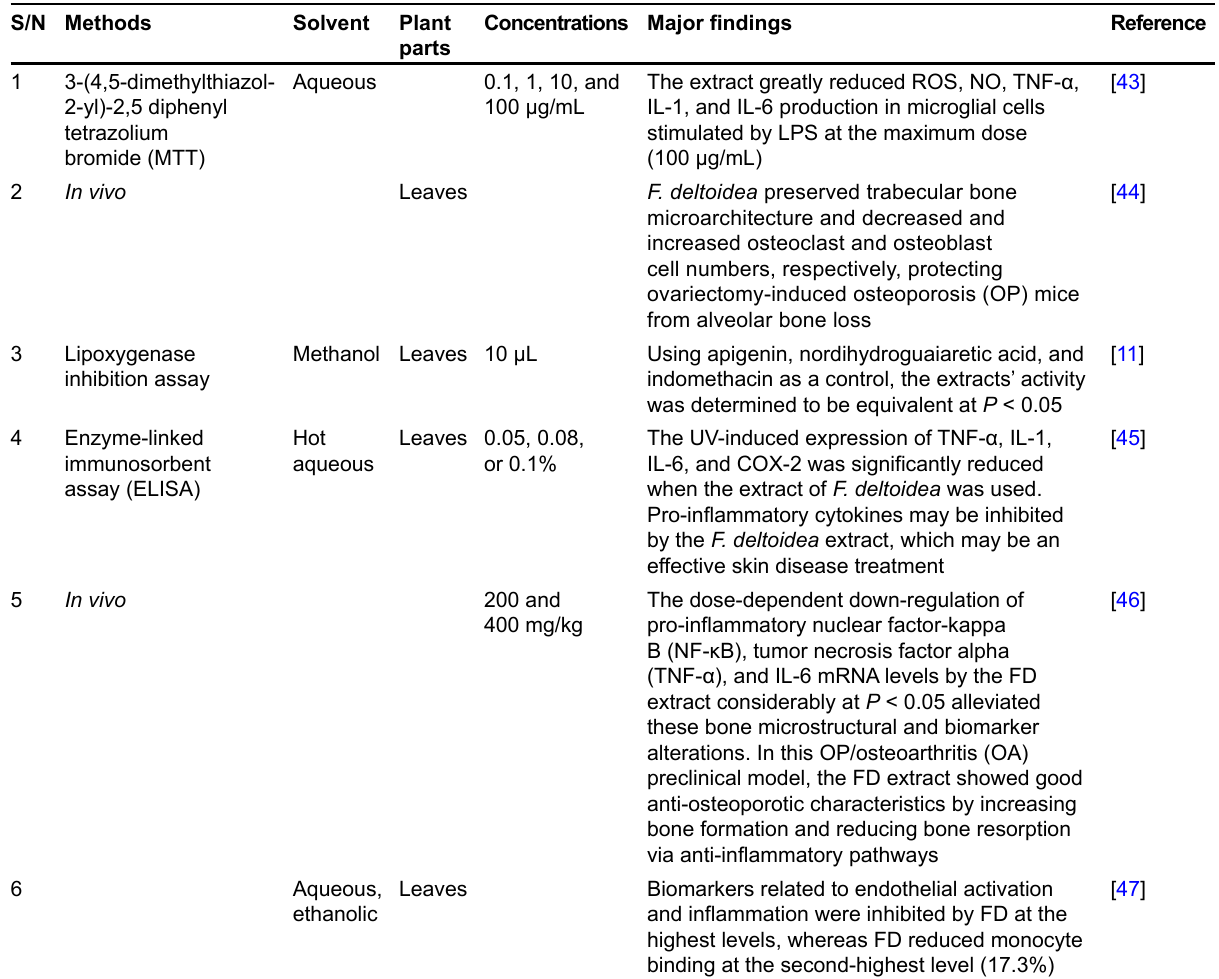
Explor Target Antitumor Ther. 2023;4:57–88 |